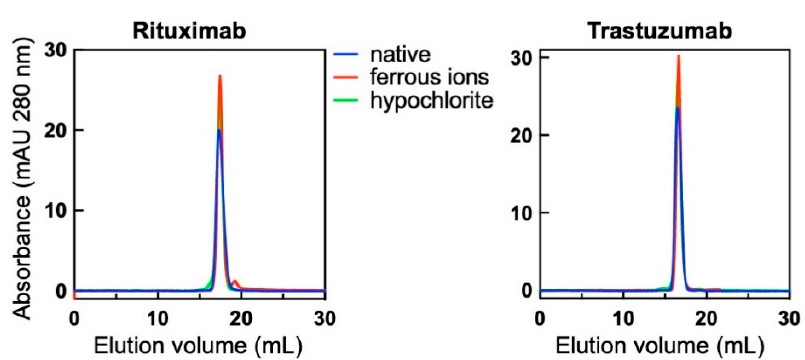
Figure 6. Molecular composition of native Abs and those treated with redox agents therapeutic. Rituximab and Trastuzumab at 1 mg/mL were exposed to 500 µ M final concentration of FeSO 4 or 200 μ M NaOCl. Native and treated Abs were injected through Superose 6 size-exclusion profiles and their profiles recorded at 280 nm. Blue lines indicate the profile of native Abs, the red lines of Fe 2+ ion-treated and green lines OCl − ion-exposed Abs. Of note, Rituximab showed slight retention to the column evident by the larger elution volume of native Ab as compared to Trastuzumab.